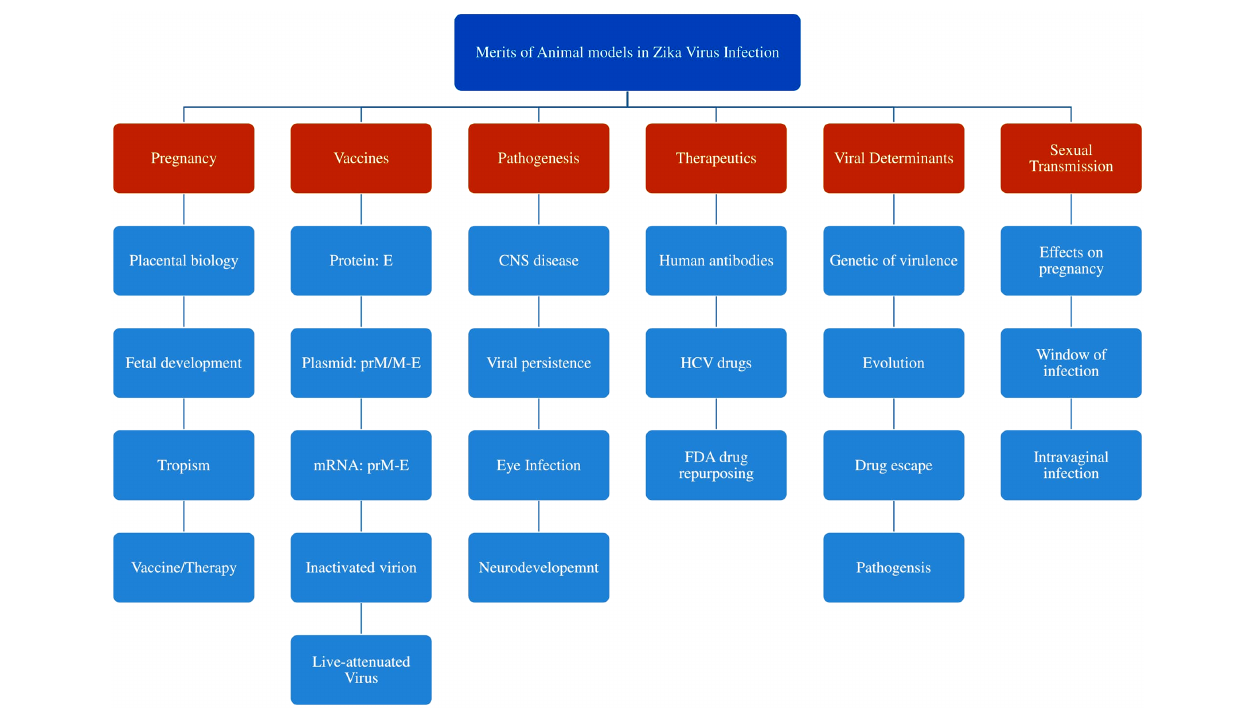
FIGURE 3 | Various applications of animal models in ZIKV research included the study of pathogenesis and transmission, viral determinants and developments of vaccines and